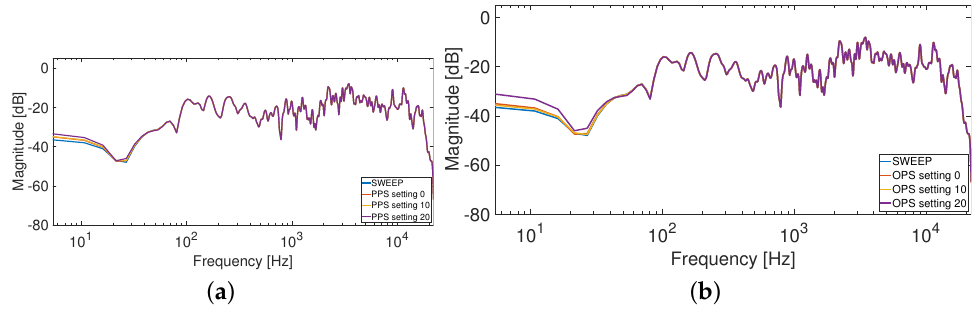
Figure 8. HRTFs measurement at driver position from the left loudspeaker to the left ear, comparing different distortion settings (0,10, and 20) using the MIC-100. The sweep is compared to ( a ) PPS Legendre and ( b ) OPS Gaussian. A smoothing of 1/12 octave band was applied to the responses. Subsequently, white Gaussian noise was added to output signals, resulting in an SNR of 40 dB, in order to evaluate the effect of noise. Each measurement was repeated 100 times using a different output noise every time and the final LSDs values were obtained by the average of the 100 repetitions. Figure 9 shows the obtained results. In this case, the curves related to the OPSs are higher because of a noise gain bigger than 1. In fact, the noise gain of OPS with Gaussian input is 8.8 dB, while the noise gain of OPS with uniform input is 12.5 dB. These values are so large because of the short length of the OPS sequences. The length is similar to the one used for HRTF measurements, but the effect of noise on short-length OPSs is more evident than on the longer-length OPSs used for room impulse response (RIR) measurements [40]. Looking at Figure 9, the best results are presented by the PPSs that have a noise gain of 1, while the exponential sweep is more sensitive to noise, as proved by the raised curve of the